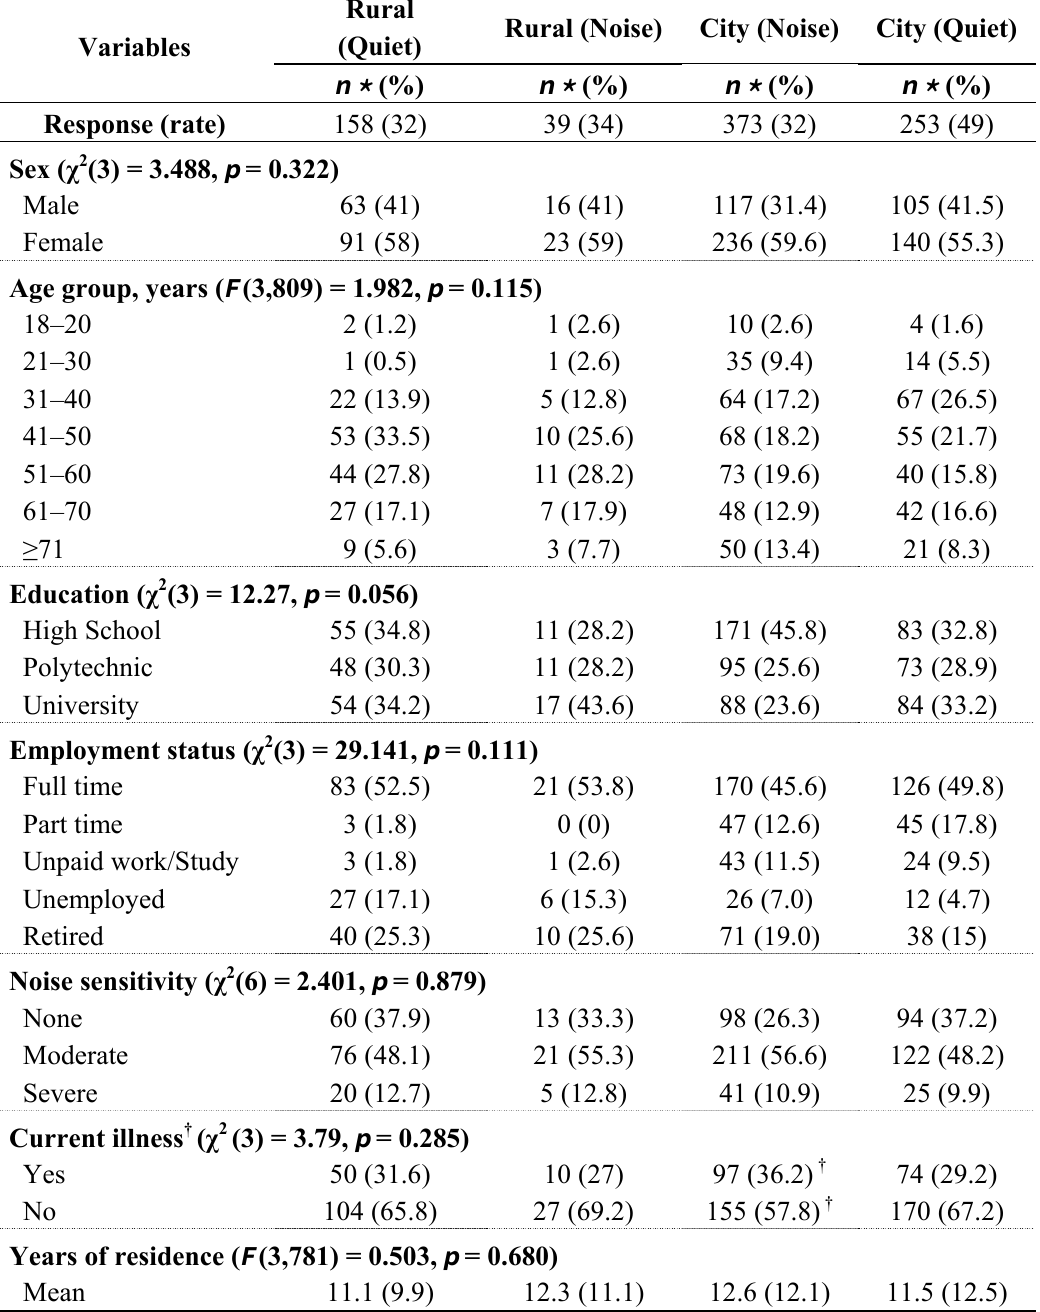
Table 1. Self-reported personal characteristics of the study sample presented by area. Inferential tests, including chi-square ( χ 2 ) and ANOVA ( F ), were undertaken to test differences across